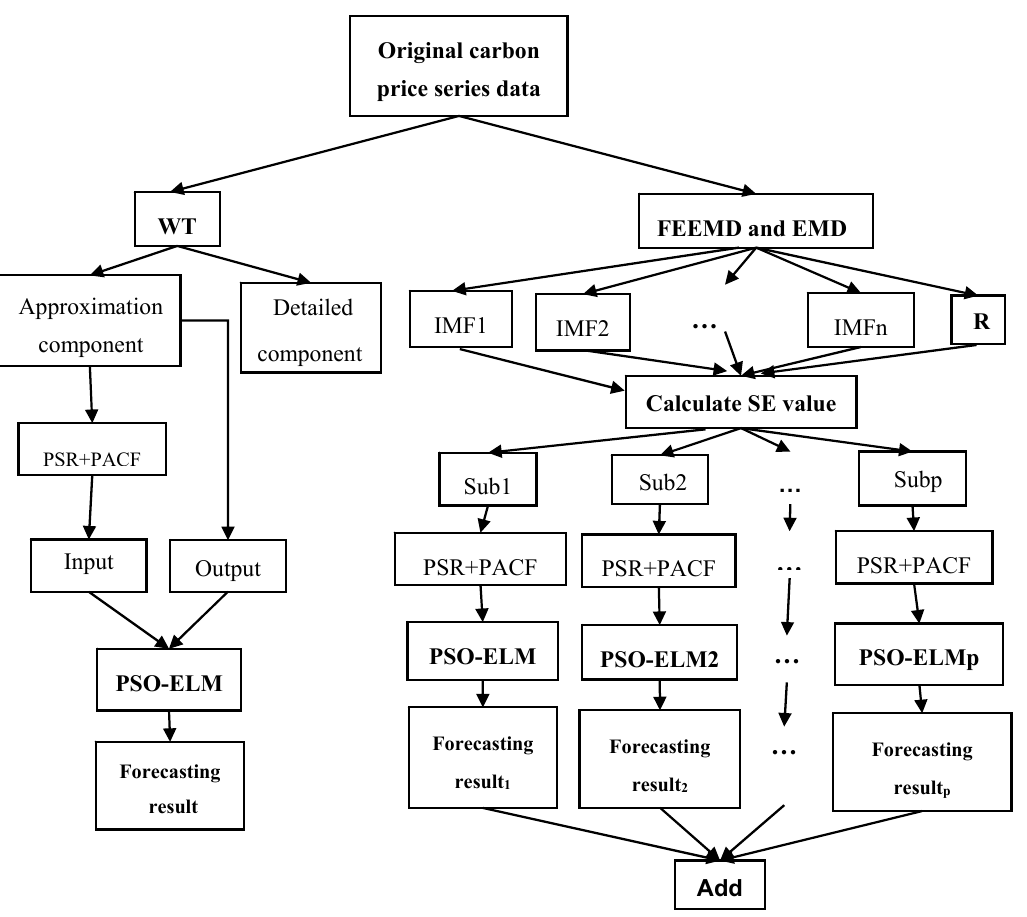
Figure 3. The framework of the proposed forecasting models. IMF, intrinsic mode function. PACF, partial autocorrelation function.